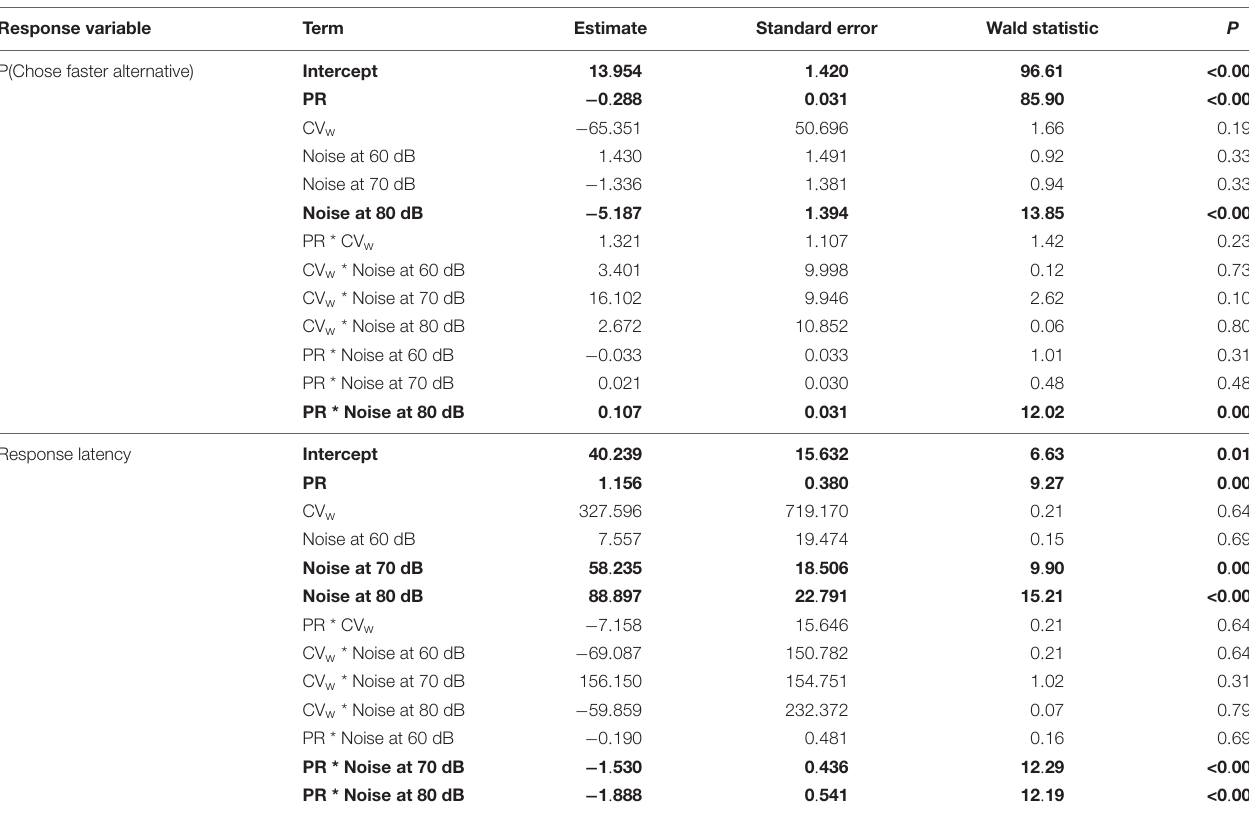
TABLE 1 | Output from two GEE models – one for the proportion of subjects choosing the population mean pulse rate over a slower pulse rate and one for response latency – examining the effects of the realized mean pulse rate (PR) of the slower pulse rate stimulus, arithmetic mean of the realized coefficients of variation in the two alternative stimuli (CV w ), and ambient noise level (Noise), including all two-way interactions ( N subjects = 289, N trials = 3,298). Response